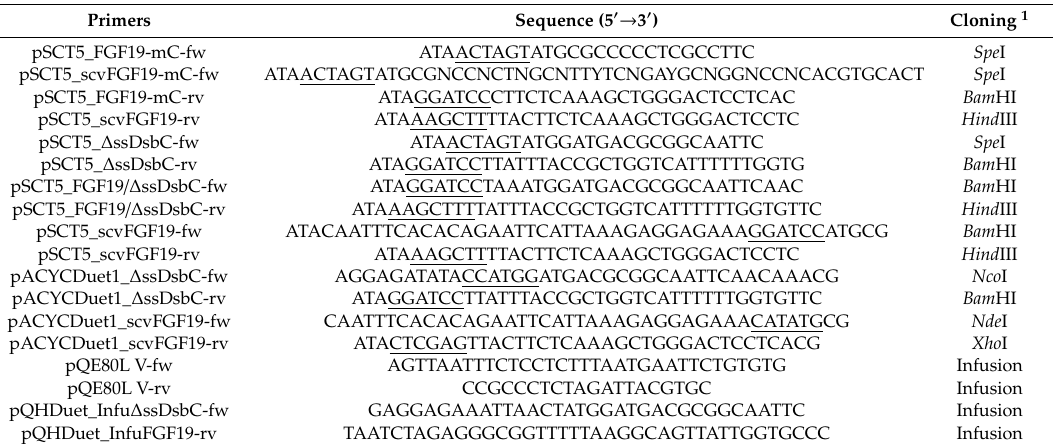
Table 1. List of primers used in this